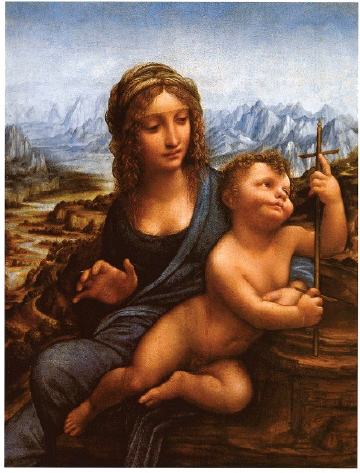
Figure 4. Leonardo da Vinci—Madonna of the Yarnwinder (1501).